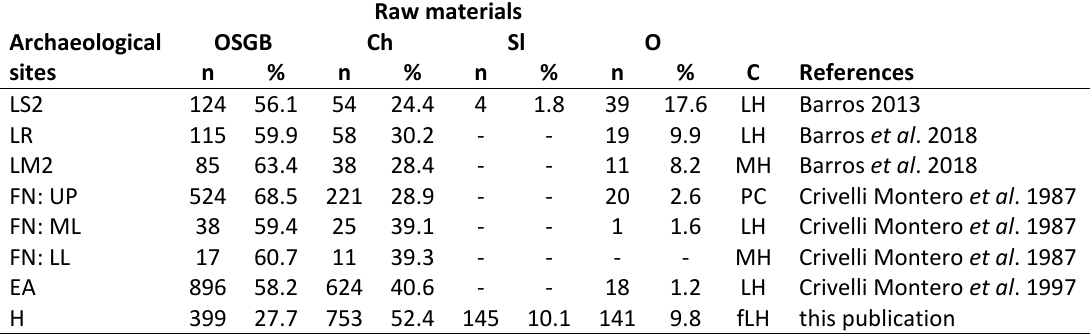
Table 1. Raw material frequencies in sites located in the basin of the Salado creek. Abbreviations = LS2 = Laguna Seca 2; LR = Laguna Redonda; LM2 = Laguna Muscar 2; FN = Fortín Necochea; UP = Upper levels; ML = Middle levels; LL = Lower levels; EA = Escuela Agropecuaria; H = Hangar; OSBG = Orthoquartzite SBG; Ch = chert; Sl = Silicified limestone; O = Other raw materials; C = Chronology; LH = Late Holocene; MH = Middle Holocene; fLH = final Late Holocene; PH =